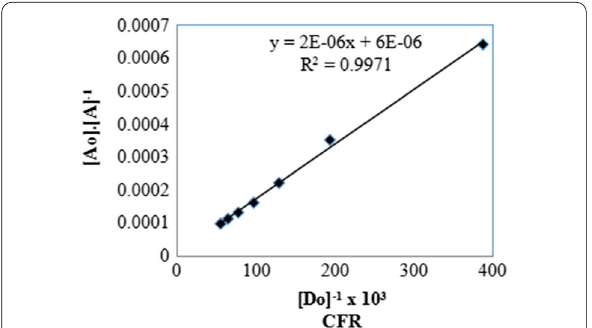
Fig. 5 Benesi–Hildebrand plot for charge transfer formation between CFR and N-(2,4-DN1NL)